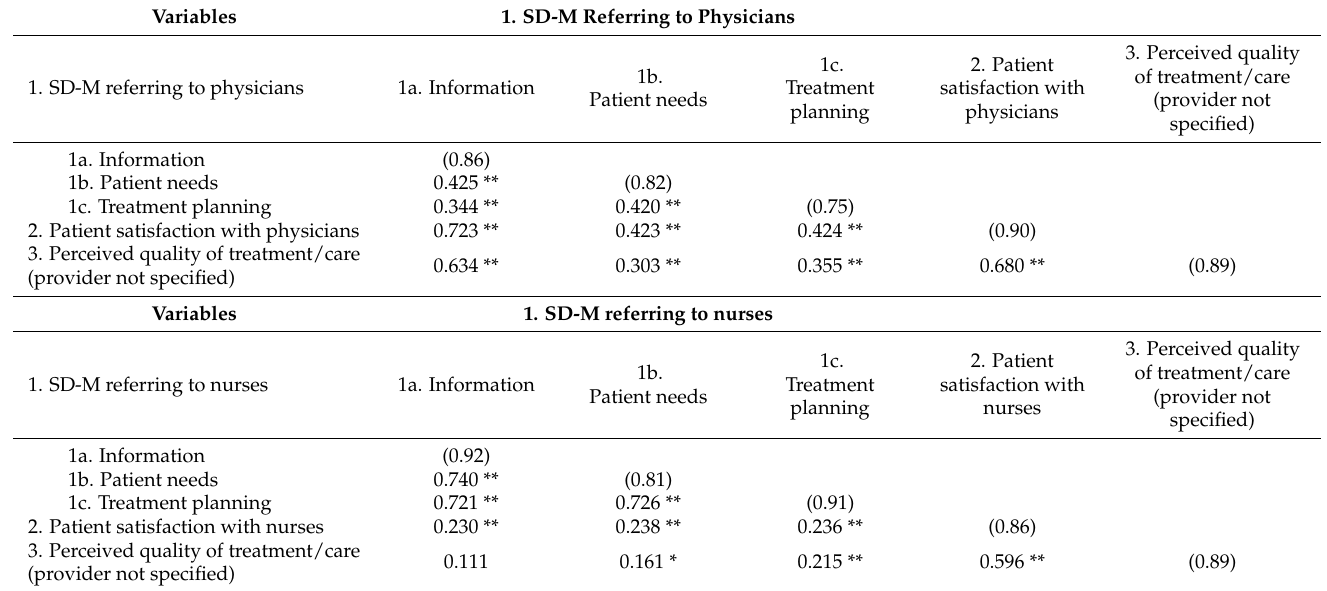
Table 3. Correlation analysis and Cronbach’s Alpha for the study